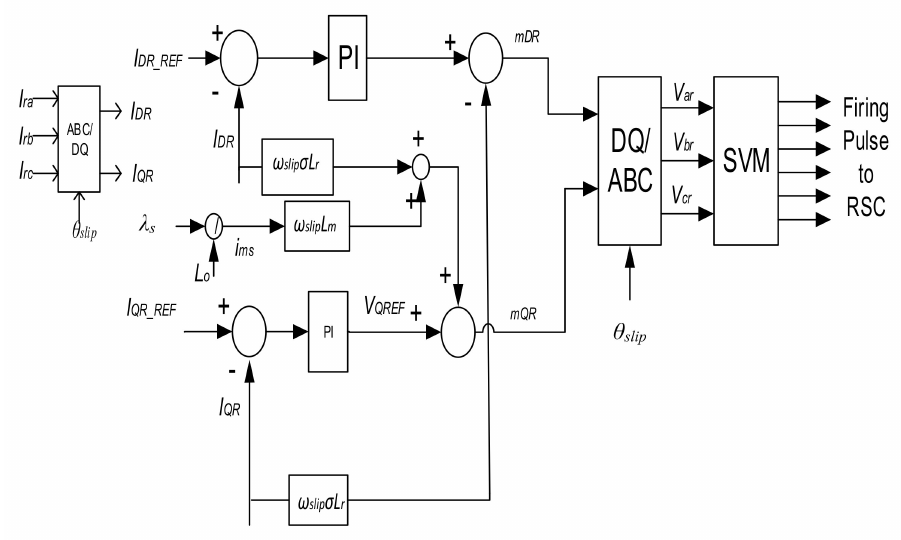
Figure 7. Rotor side converter (RSC)